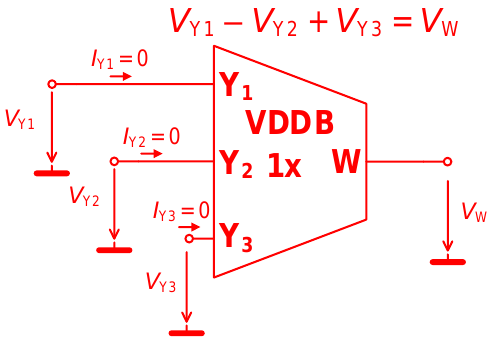
Figure 2. Schematic symbol and interterminal transfer relation of the voltage differencing differential buffer (VDDB).